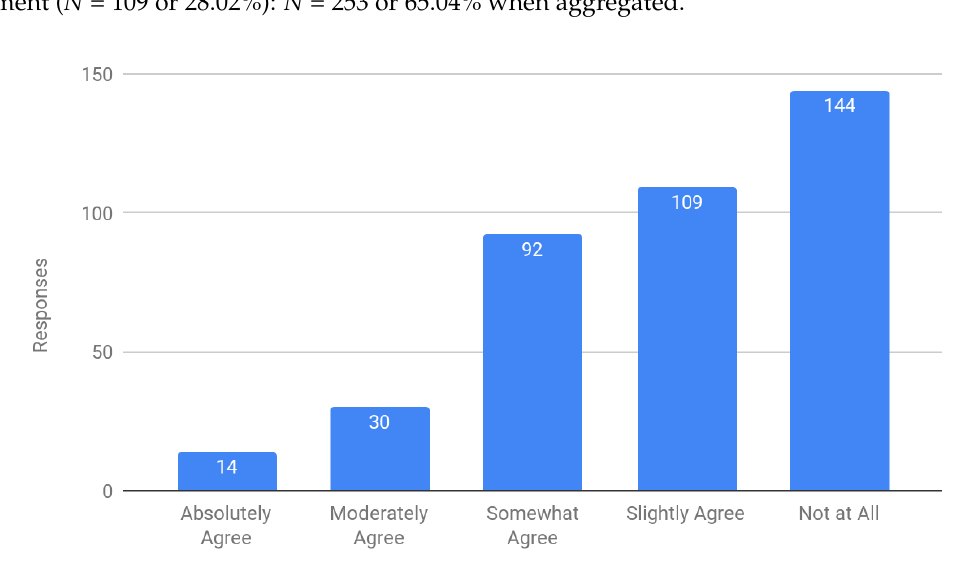
Figure 2. Question 23: Religion is Dangerous ( N = 389).